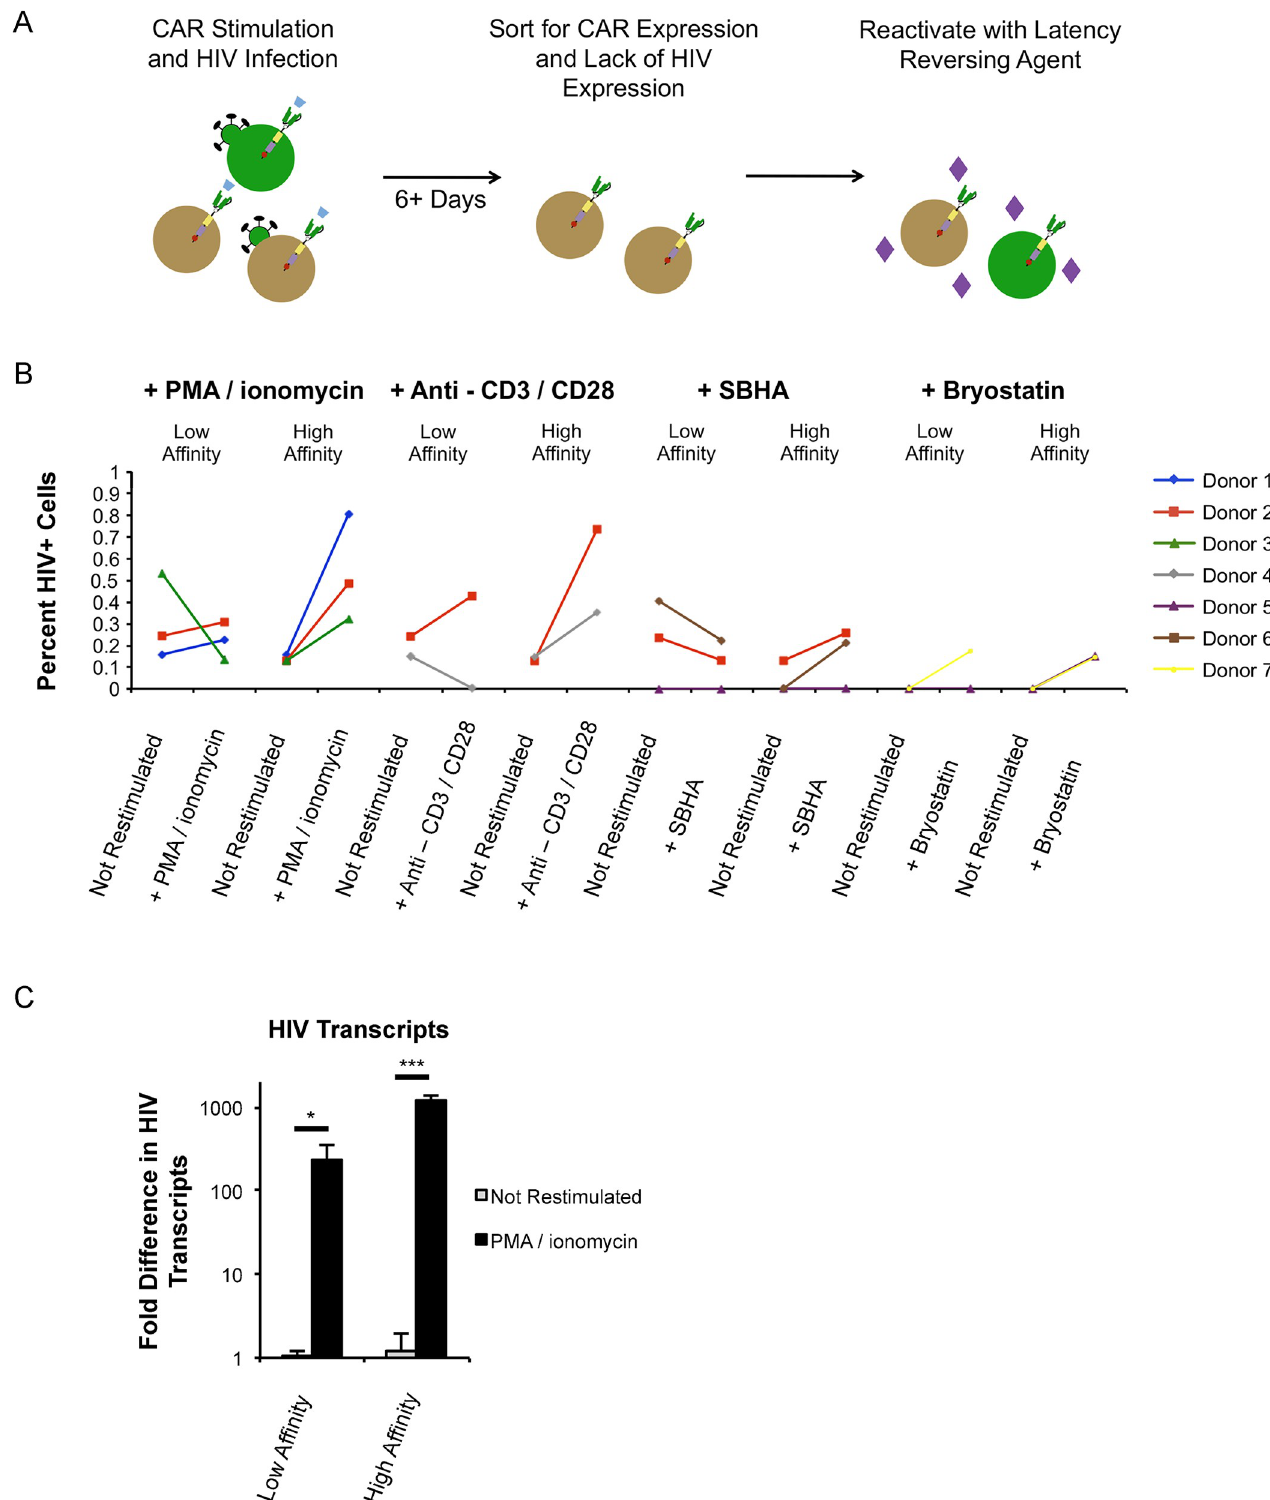
Fig 5. Robust signals during HIV-1 infection establish an inducible latent reservoir. ( A ) Outline of experimental plan to enrich for latently infected cells following infection. Primary CD4+ T cells are infected with VSV-G pseudotyped BRU- Δ Env-GFP and GFP-negative cells are sorted to enrich for latently infected cells. ( B ) Percent GFP+ HIV-expressing cells after stimulation of latent cells with various latency-reversing agents: PMA plus ionomycin, antibodies to